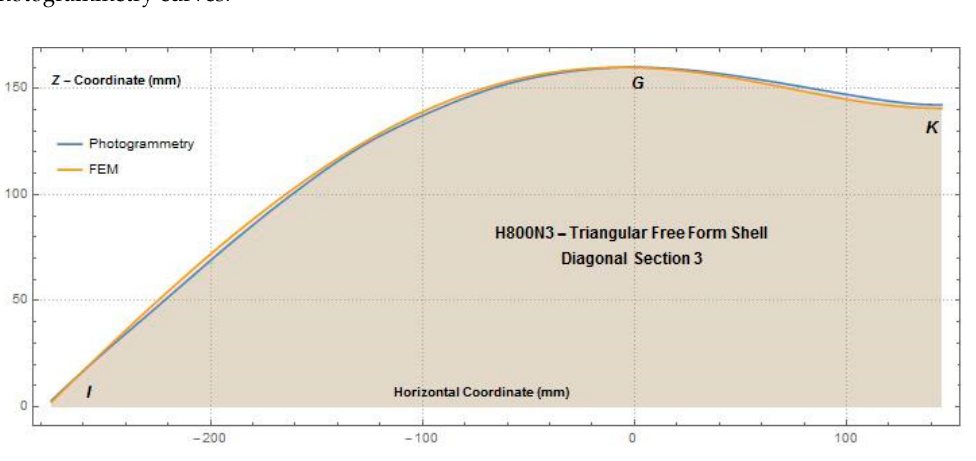
Figure 19. Diagonal cross-section defined by the plane IGK : Finite Element Method (FEM) vs. Photogrammetry curves.